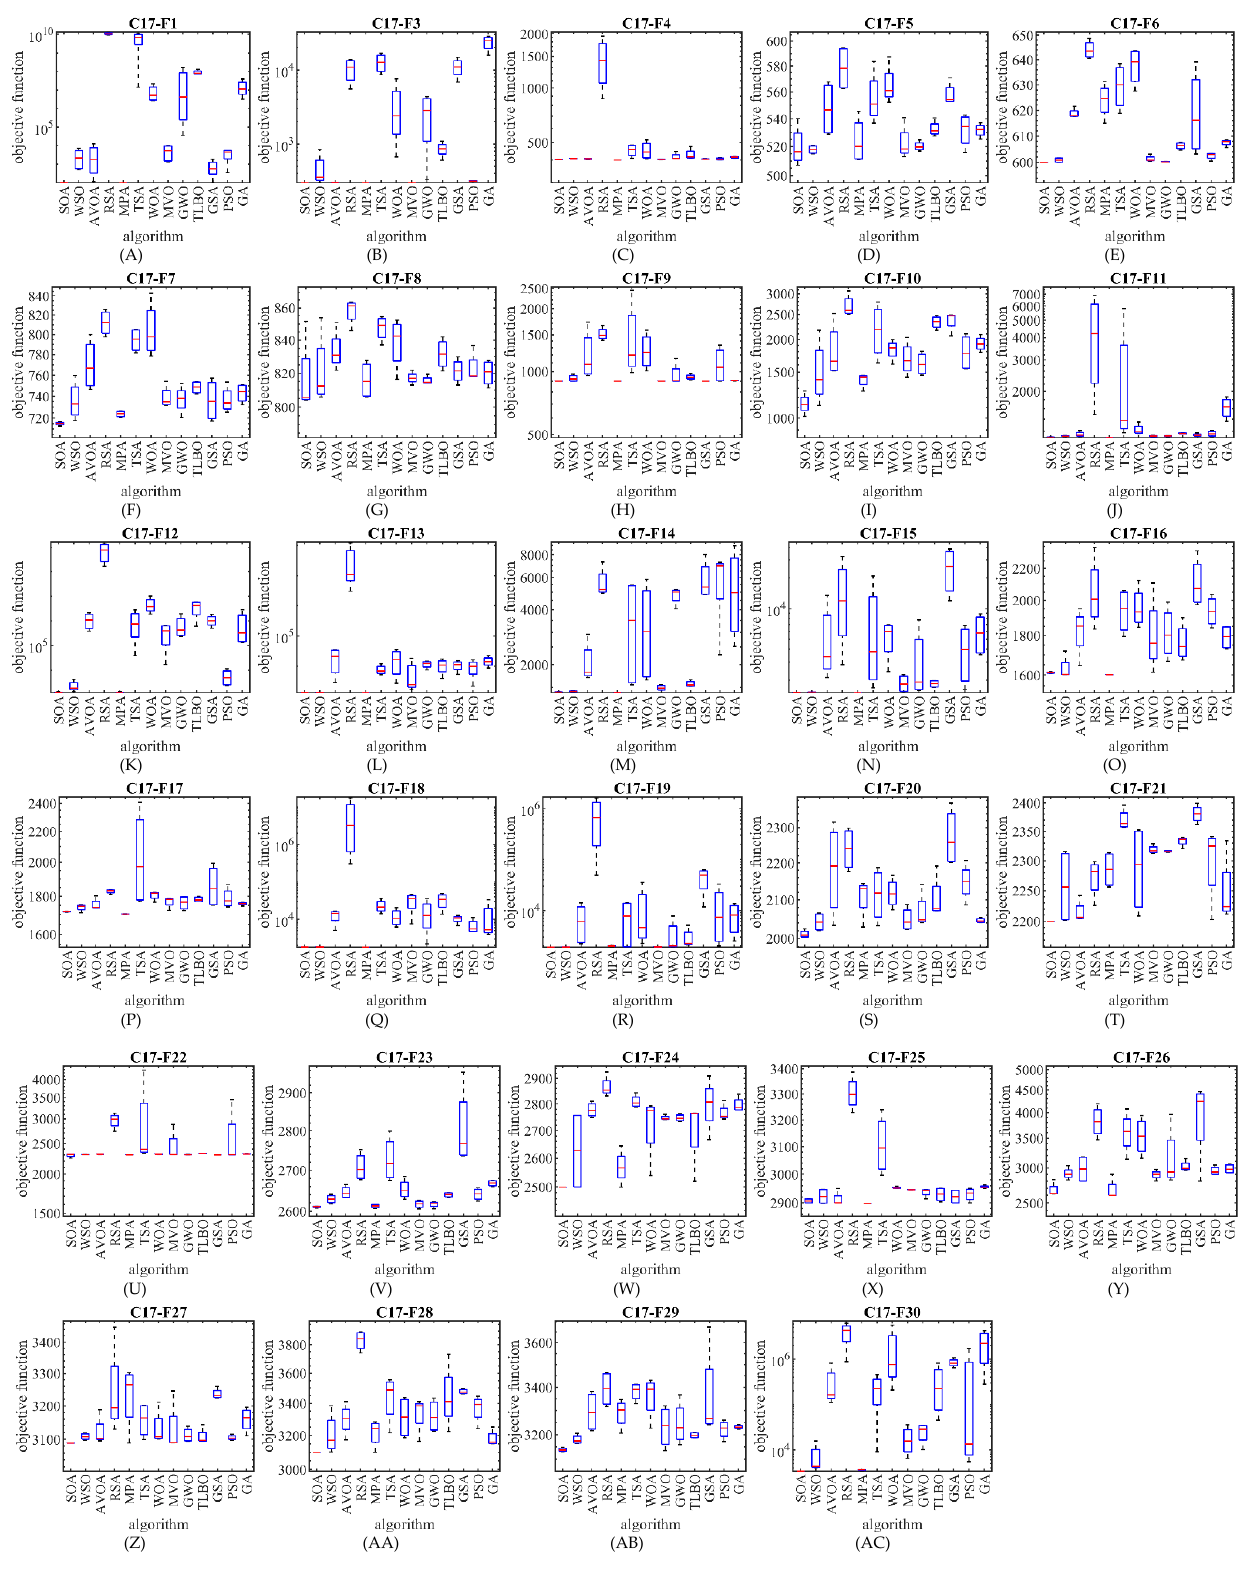
Figure 2. Boxplot diagram of SOA and competitor algorithms performances on the CEC 2017 test suite (for the dimension 𝑑 = 10 ).